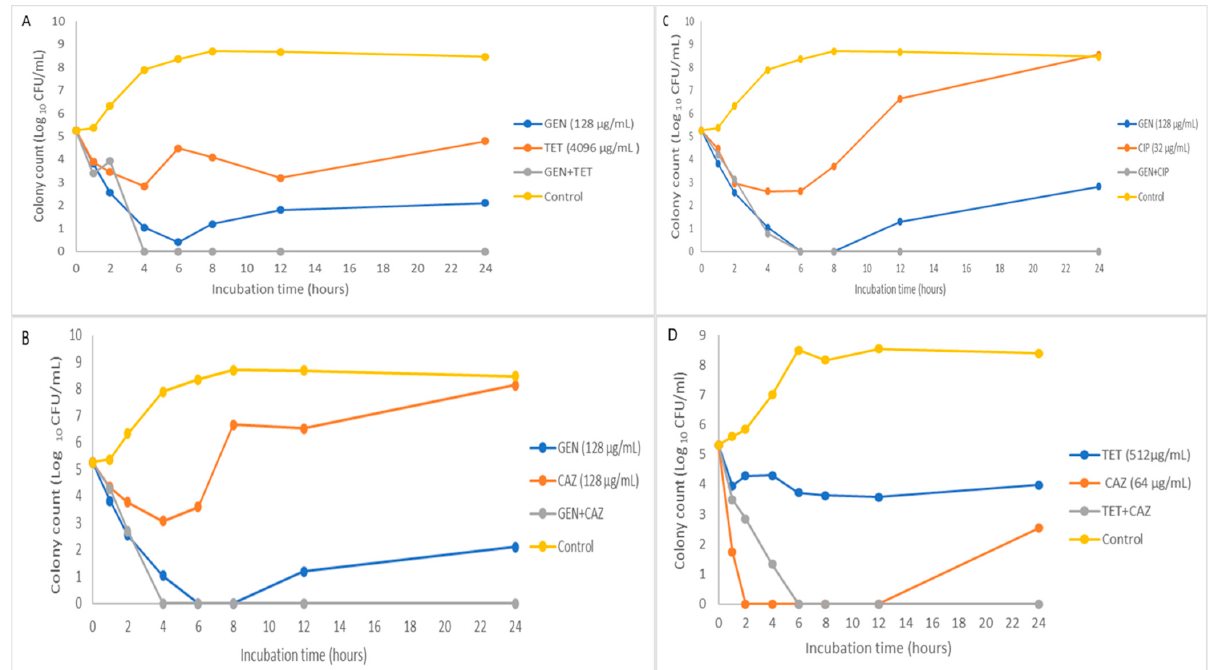
Figure 1. Time ‐ kill curves for antimicrobials in combination at various minimum inhibitory concen ‐ tration (MIC) values. ( A – C ) The combination of gentamicin at MIC with tetracycline, ceftazidime, and ciprofloxacin, respectively, against multidrug ‐ resistant (MDR) K. pneumoniae (KP1). ( D ) Drug combination against MDR E. coli (E1).